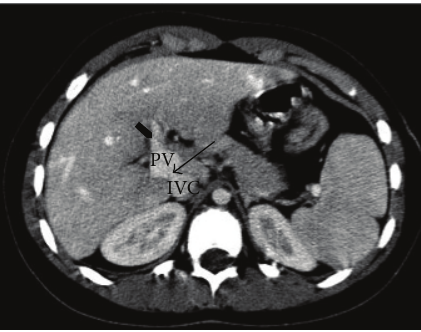
Figure 2: Axial contrast-enhanced CT images. The arrow shows the shunt between the portal vein (PV) and the inferior cava vein (ICV); at the hepatic hilum, the PV appears enlarged with only one intrahepatic portal branch (arrowhead).